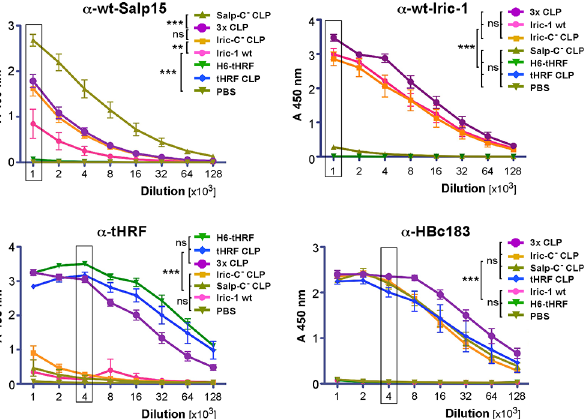
Fig 7. Antibody specificities in mouse IS induced by different tick protein preparations. Groups of 4 to 8 mice were immunized on day 0, 14, 28 and 60 with 10 μ g protein per shot in the presence of MPL adjuvant, or with PBS as negative control. Antigens were i) free wt-Iric-1 (Iric-1 wt) released from a DsbA-Iric-1 fusion [10]; ii) H6-tHRF (Fig 3A); iii) spREV Sa_C - CLPs (Salp-C - CLP; Fig 6A); iv) spREV Ir_C - CLPs (Iric-C - CLP; Fig 6B); v) c149-tHRF CLPs (Fig 3B); vi) a 1:1:1 (per weight) mixture of all three CLP preparations (3x CLP). Two-fold serial dilutions from 1:1,000 to 1:128,000 of individual IS obtained on day 67 p.i. were analyzed in duplicate by ELISA. Plots show the mean absorbance at 450 nm ± SEM versus dilution. Significance of differences between groups was assessed at the highest dilution where the most strongly reactive IS per series reached the maximum value (boxed). (A) Anti-wt-Salp15 response. Solubilized H6-Salp15 served as test antigen. (B) Anti-wt-Iric-1 response. Free wt-Iric-1 released from DsbA-Iric-1 served as test antigen. (C) Anti-tHRF response. SEC purified H6-tHRF served as test antigen. (D) Anti-HBc183 response. Sucrose gradient purified HBc183 CLPs served as test antigen. Note the strong specific responses to the protein antigens present in the respective vaccines, and the high crossreactivity against wild-type Salp15 and Iric-1 induced by the CLPs presenting their Cys-free variants (see S4B Fig for direct